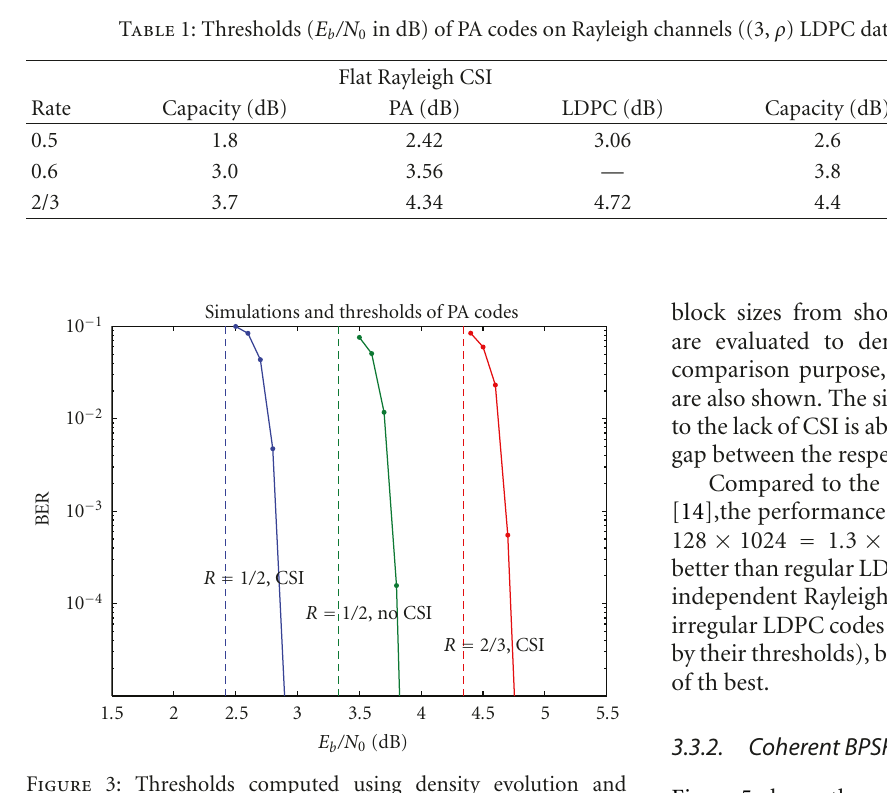
Figure 3: Thresholds computed using density evolution and simulations (data block size K = 64